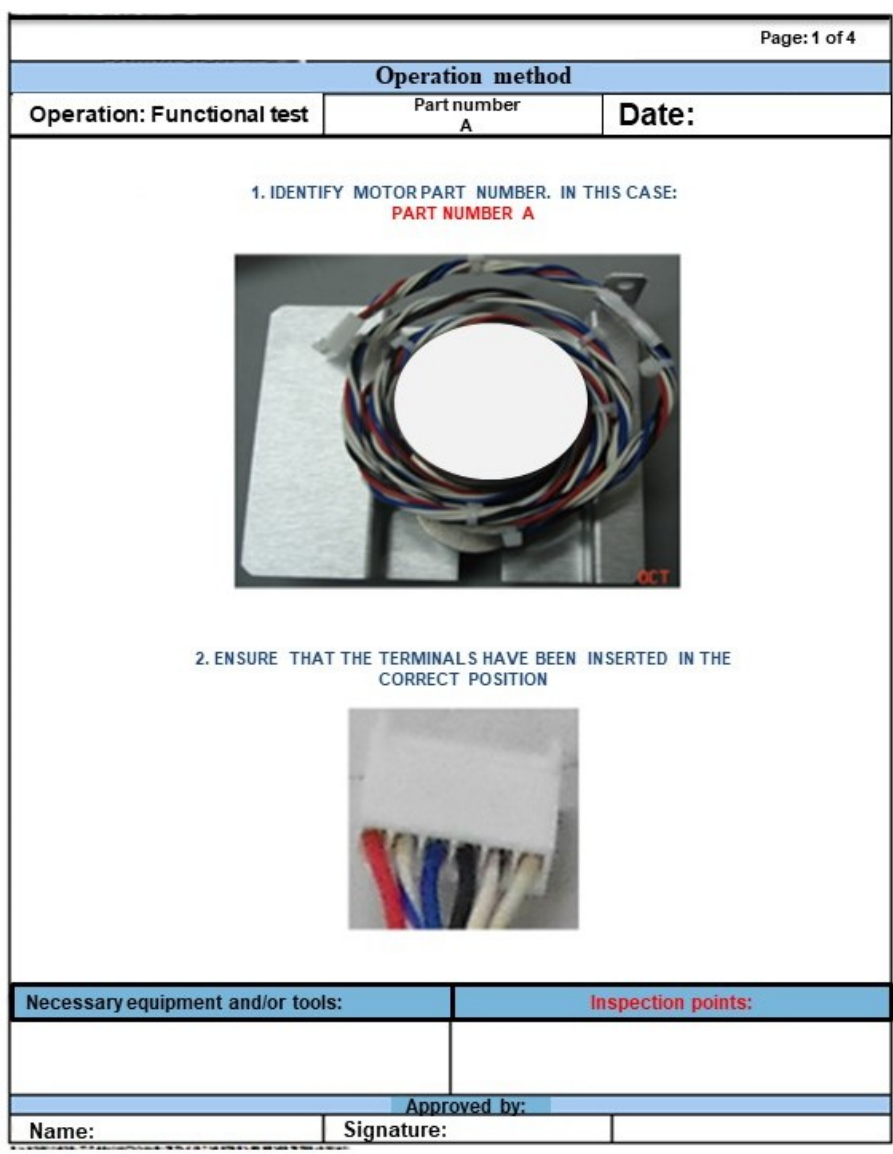
Figure 1. First Visual Aid to Conducting the Functional Test. Figure A1. First Visual Aid to Conducting the Functional